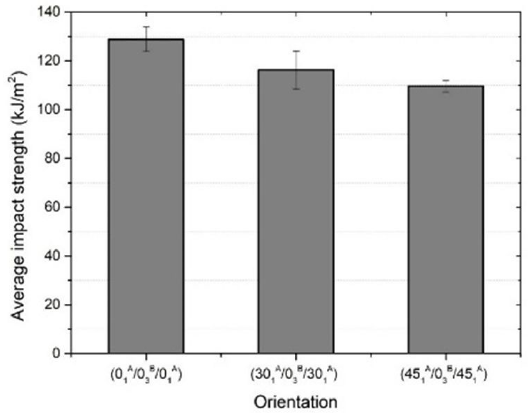
Figure 12. Average impact strength of hybrid